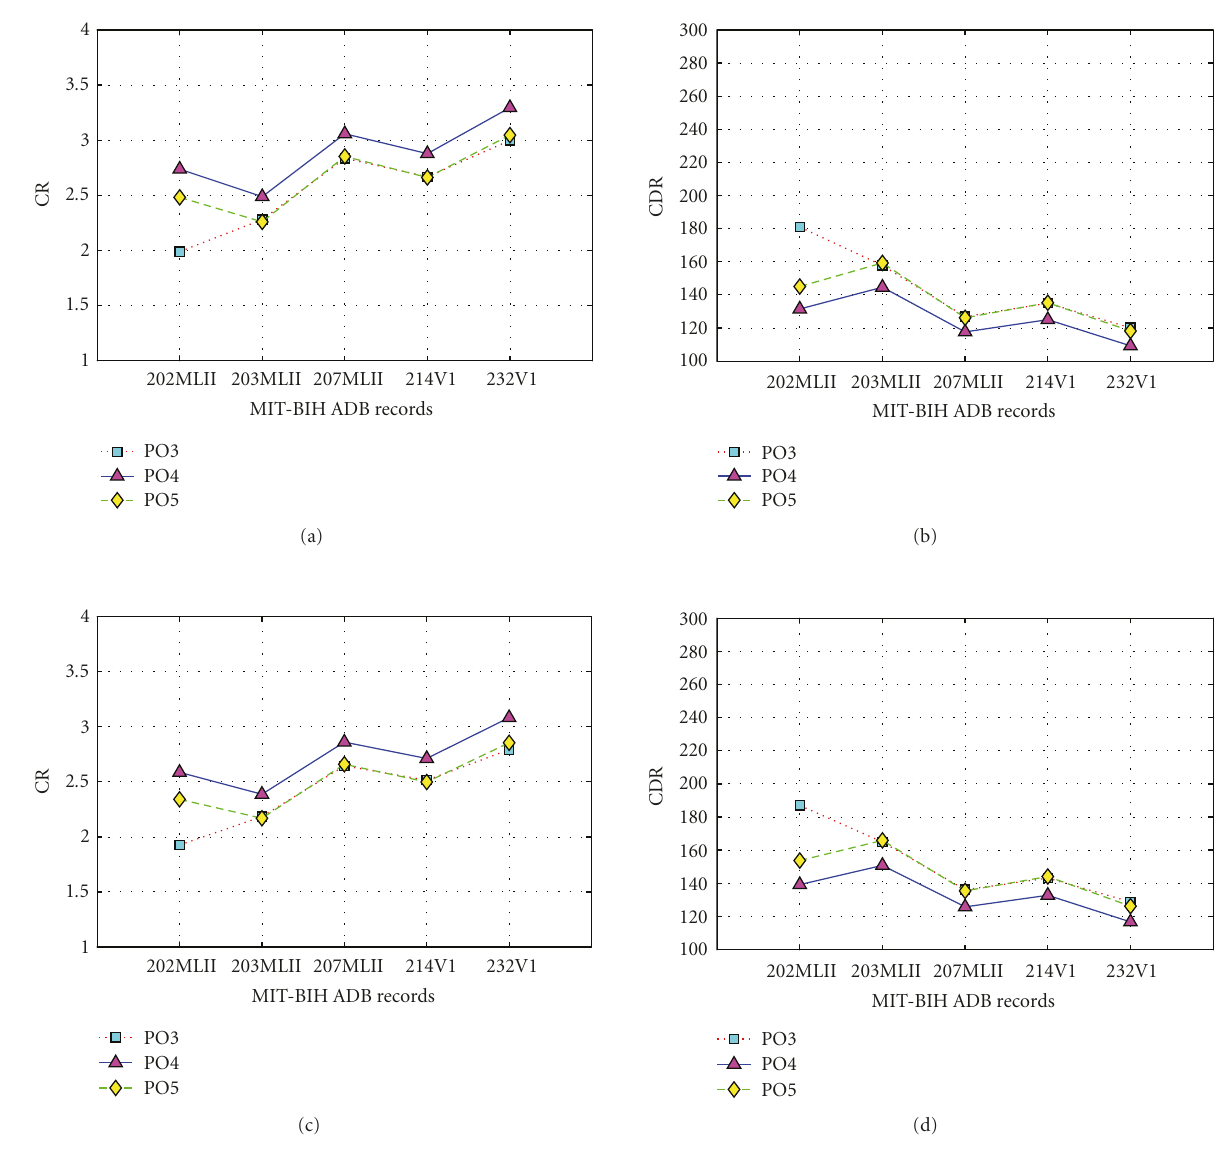
Figure 6: Compression e ffi ciency performance results on short-duration datasets with di ff erent predictor orders: (a) CR and (b) CDR for PH scheme, (c) CR and (d) CDR for PRH